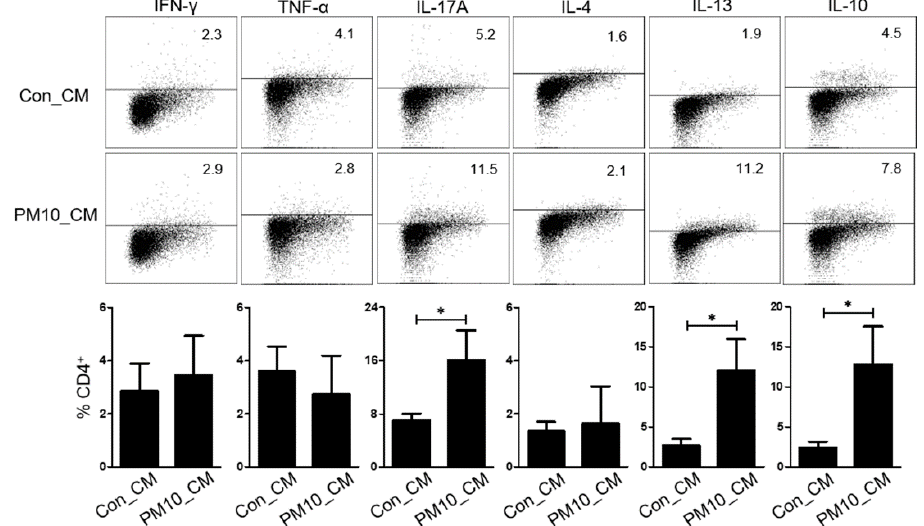
Figure 4. Effect of human nasal polyp derived fibroblast-conditioned media (NPDF-CM) treated with PM10. The graphic data represents the means ± SEM ( n = 3). * p <